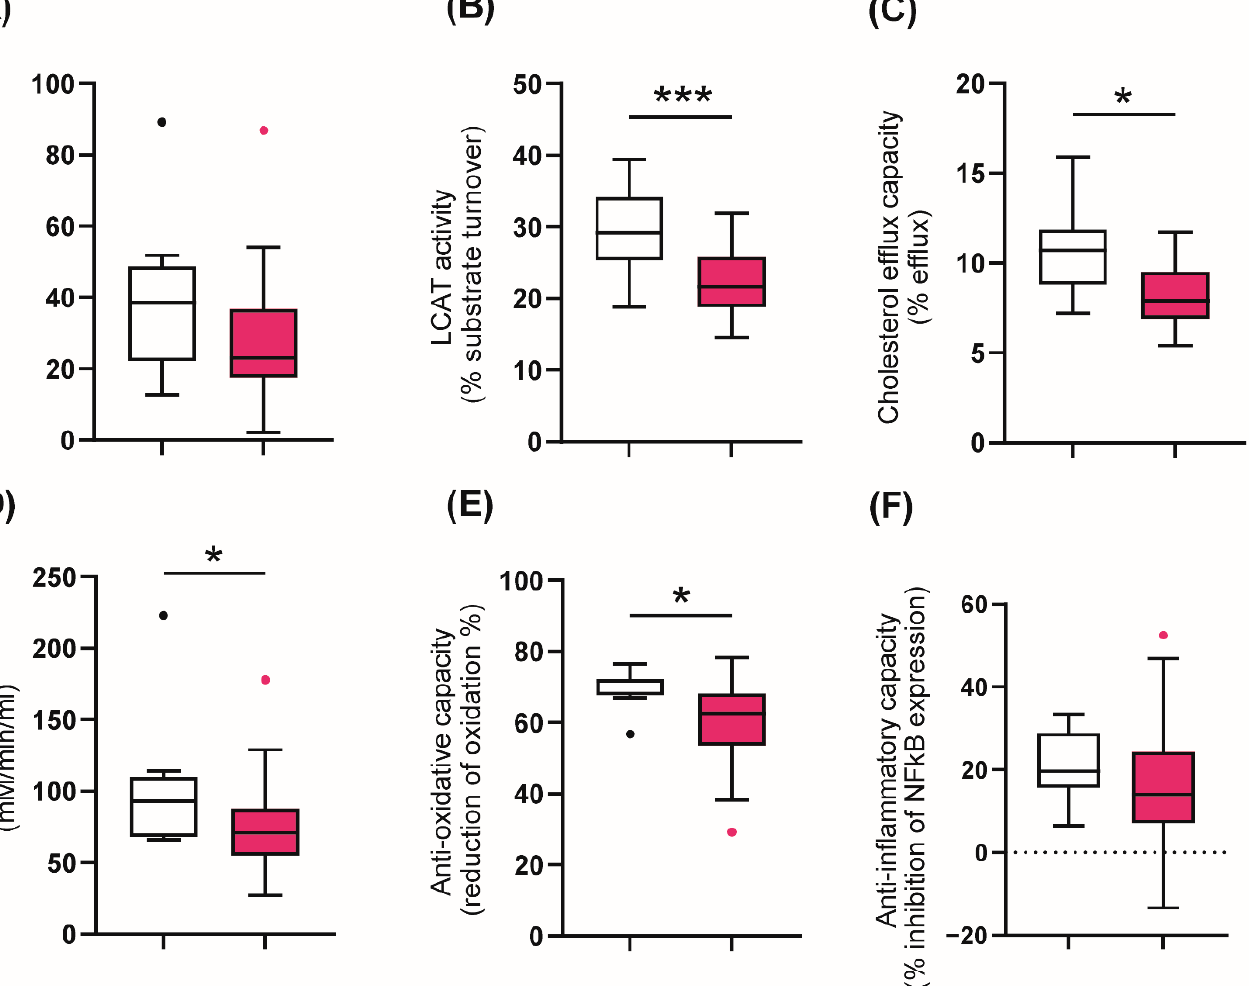
Figure 3. Tukey boxplots of HDL-related parameters in COVID-19 patients ( n = 48) stratified by different treatment options. Oxygen therapy included treatment with oxygen mask, oxygen with CPAP and mechanical ventilation. ( A ) HDL-cholesterol levels (mg/l); ( B ) LCAT activity (% substrate turnover); ( C ) Cholesterol efflux capacity (%); ( D ) arylesterase activity of PON1 (mM/min/mL se- rum); ( E ) anti-oxidative capacity (% reduction of oxidation); ( F ) anti-inflammatory capacity (% inhi- bition of NF κ B expression); ( G ) logSAA ( μ g/mL). Differences between the two groups were ana- lyzed by the Mann–Whitney U test. Outliers are represented by black and red dots. * p < 0.05, *** p < 0.001. 3.4. HDL Cholesterol Efflux Capacity Is Inversely Associated with Mortality Risk in COVID-19 Patients Death occurred in 31% of the COVID-19 patients. Using Kaplan–Meier and Cox re- gression analyses, we next assessed whether HDL-related functional parameters were as- sociated with an increased risk of death.